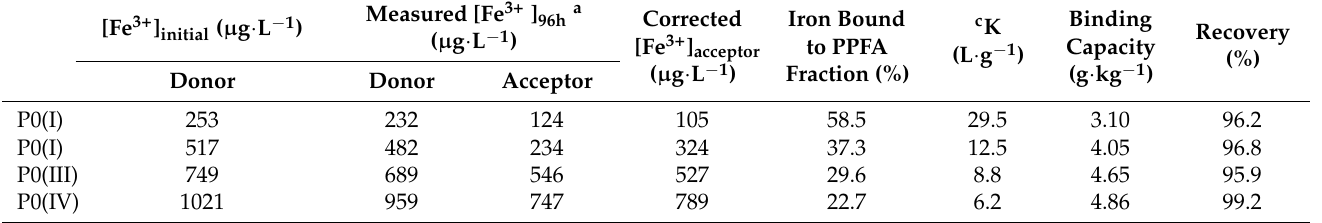
Table 3. Results of chemical speciation of iron in the solutions of PPFA at different iron concentrations.